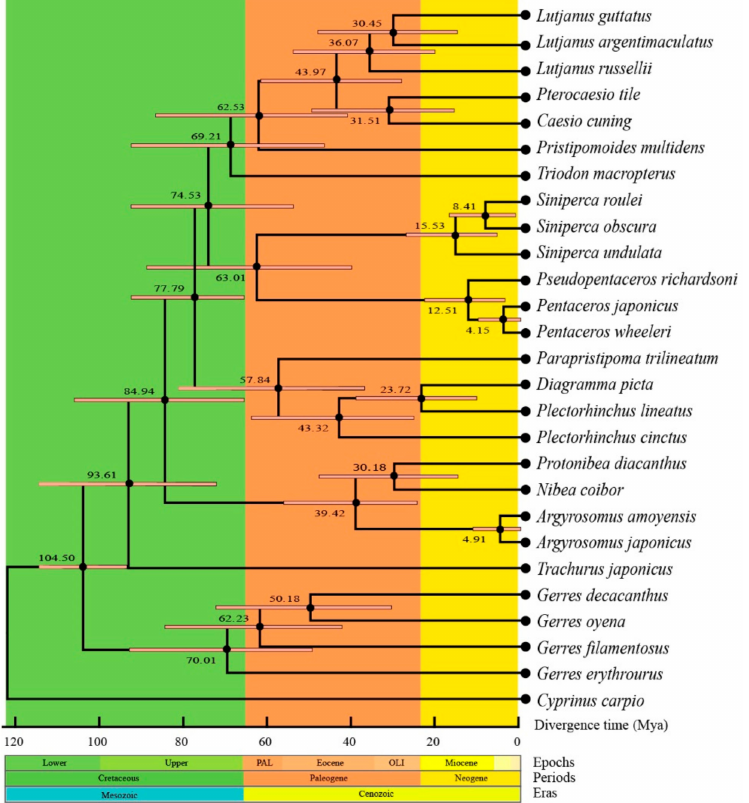
Figure 9. Divergence time analysis of 27 fish species base on Maximum likelihood topology using concatenated sequences of 13 PCGs. Numbers near the nodes indicated the estimated divergence time